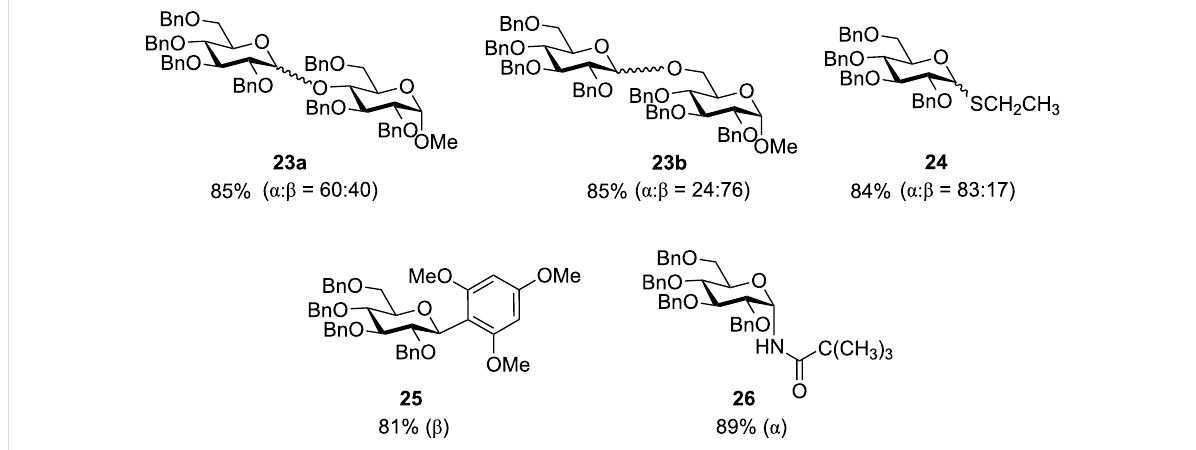
Figure 1: Representative structures of products formed by the preactivation-based dehydrative glycosylation of glycosyl hemiacetal.